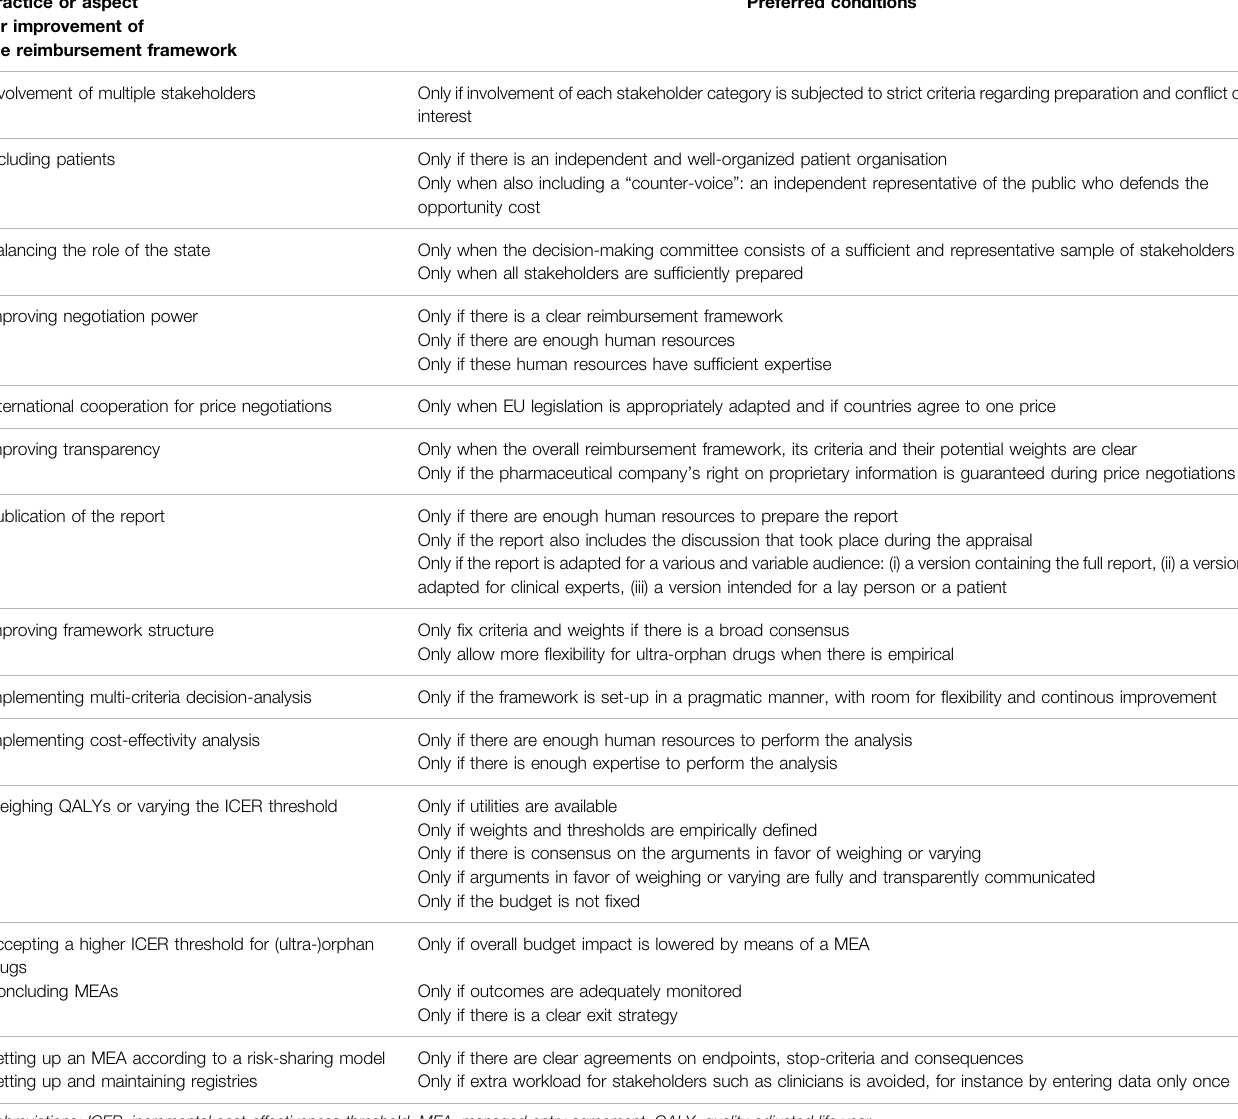
TABLE3| Aspectsofthereimbursement(valueassessmentandappraisal)processwithroomforimprovementandthepreferredconditionslinkedtoeachimprovement,as voiced by